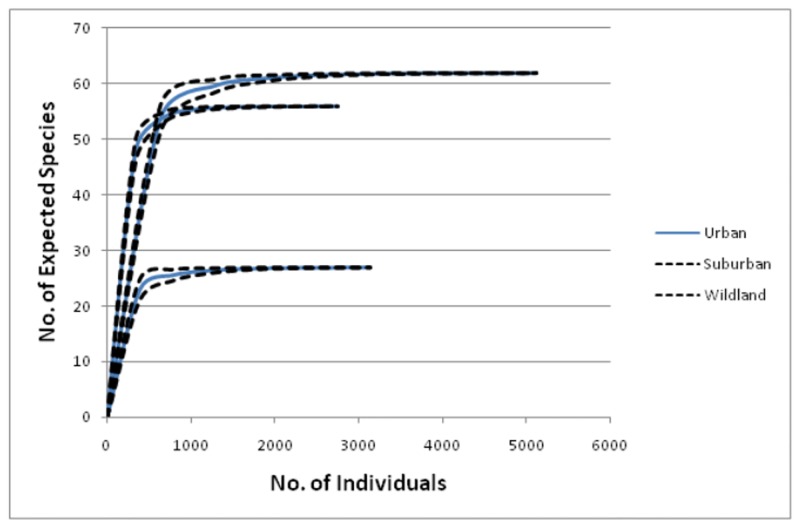
Rarefaction curves for avian species estimated from urban, suburban and wild land habitat for city Jamshedpur.Thick lines indicate mean richness and dotted lines indicate 95% confidence intervals.